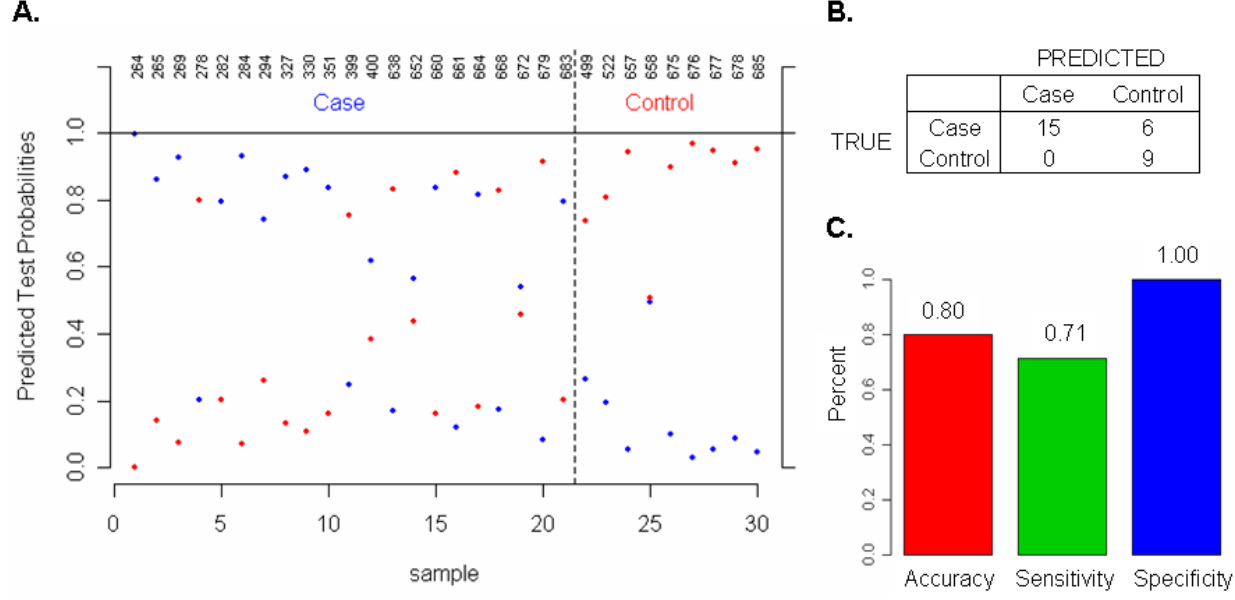
Figure 4. Validation of the 41 classifier genes using TaqMan real-time PCR assays. The expression profile of the 41 classifier genes was measured in each of the 82 samples by real-time PCR using TaqMan H Gene Expression Assays. Based on TaqMan assay data, the coefficient of the 41 classifier genes were re-learned from the 52 training samples and used to classify the status of 30 testing samples using the same method applied to microarray data. (A). Classification probabilities for each testing sample: TAA (case) vs. normal (control); (B). Contingency table summarizes the predicted and actual class membership for the testing set; (C). Classification accuracy, sensitivity and specificity.